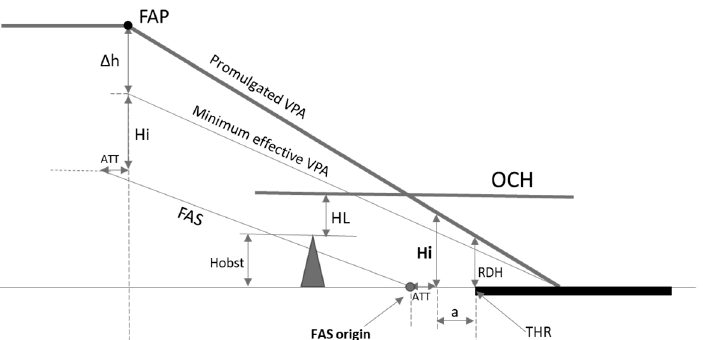
Figure 3. Final approach surface (FAS) vs. obstacle clearance height (OCH). Where: Hobst: obstacle height above runway threshold (THR); HL: height lost. Margin to be added depending on the aircraft category: OCH: obstacle clearance height.